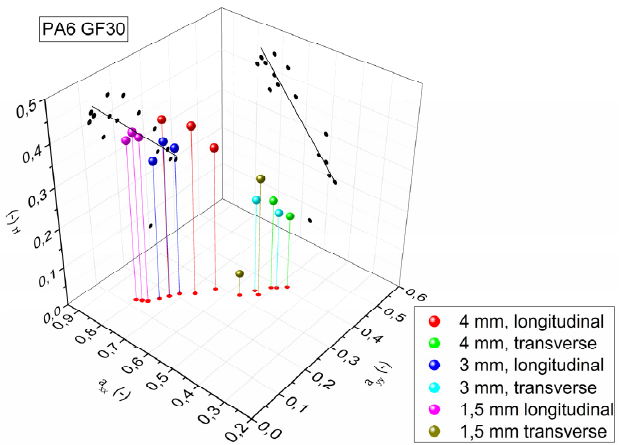
Figure 6. Poisson’s ratio for PA6 GF materials with a thickness of 1.5 mm, 3 mm and 4 mm in longitudinal and transverse orientation direction as a function of the orientation tensor components a xx and a yy ; the linear tendency is shown as a black line.